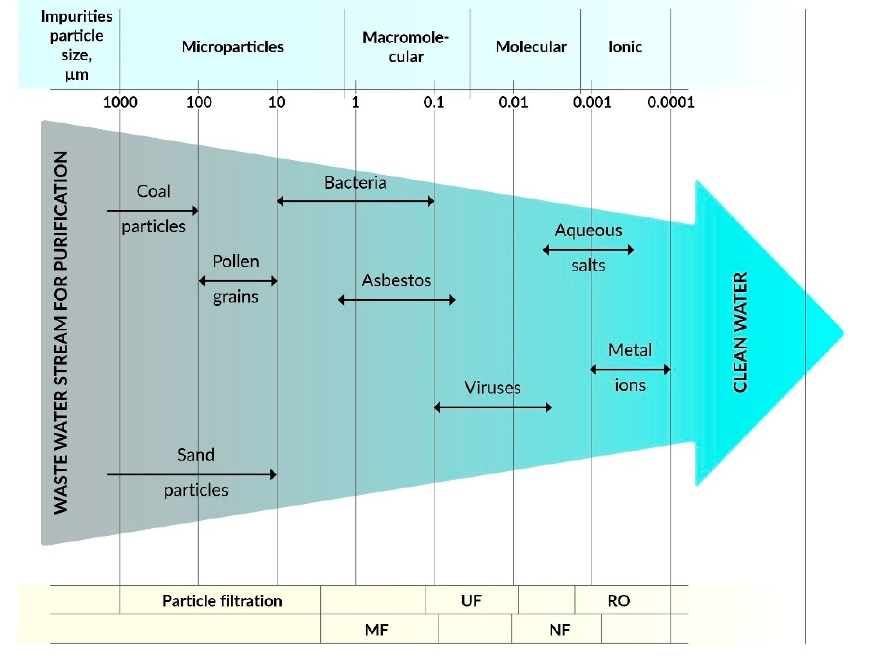
Figure 2. Dependence of filtration methods on the type of pollutants.